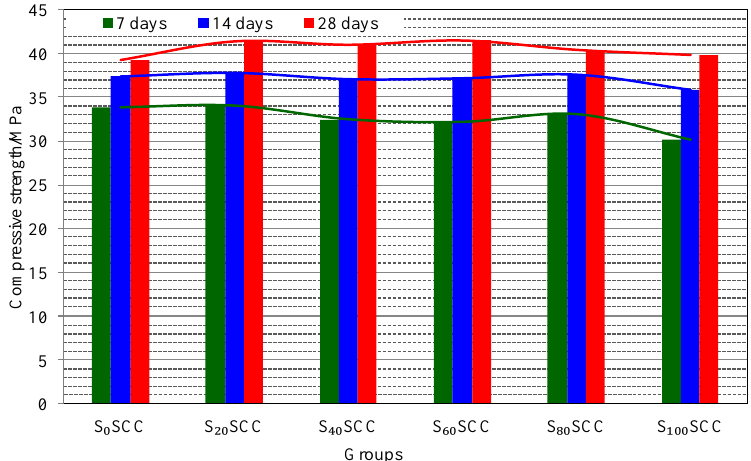
Figure 6. Grading of fine aggregates according to sieve analysis test.